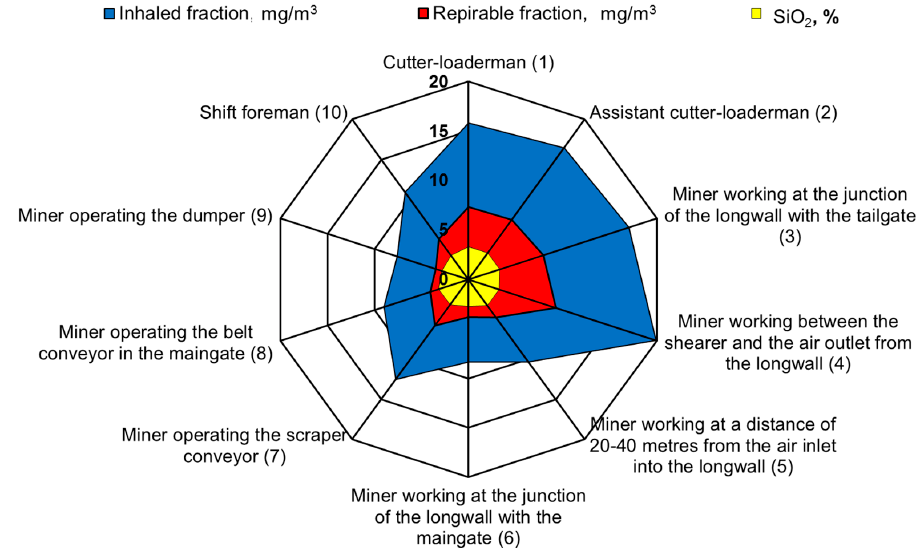
Figure 9. The average concentration of inhaled and respirable dust and the content of crystalline silica in various workstations.